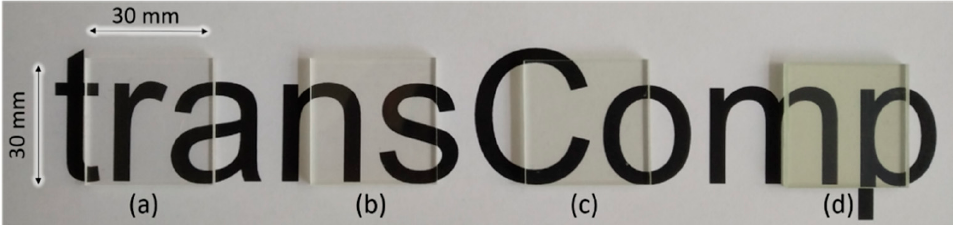
Figure 9. The naked-eye observation of the L-RTM specimens containing 0 ( a ), 5 ( b ), 10 ( c ), and 29 ( d ) layers of E-glass fabric .